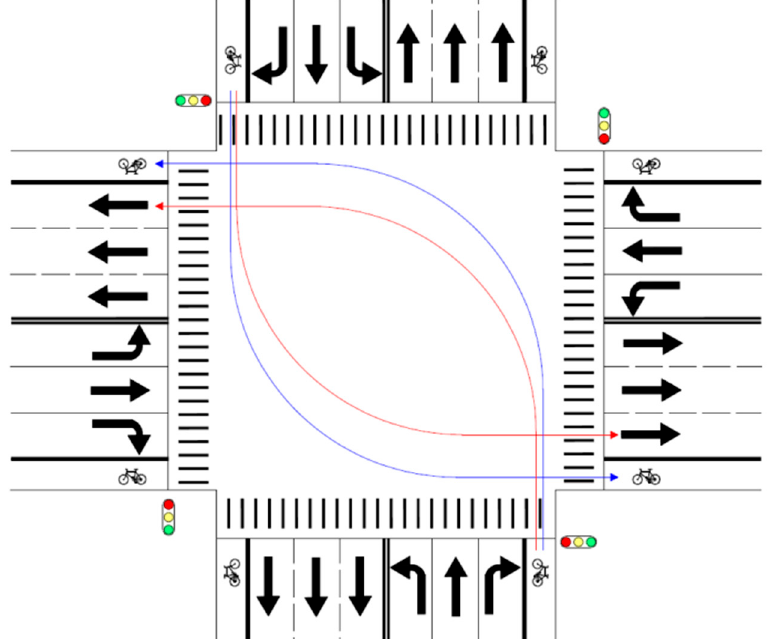
Figure 3. Trajectories of left-turning non-motorized vehicles with blue lines for choice of lane for non-motorized vehicles and red lines for choice of lane for motorized vehicles.